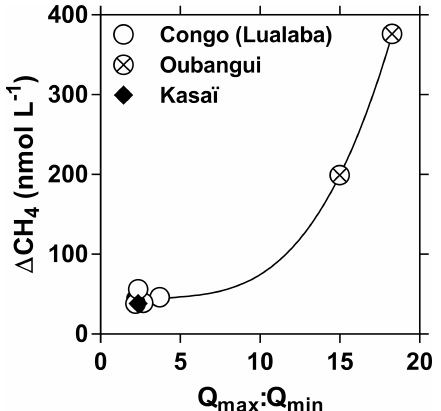
Figure 22. Seasonal amplitude of dissolved CH 4 concentration ( (cid:49) CH 4 in nmolL − 1 ) in surface waters as a function of the ra- tio of seasonal maximum and minimum of freshwater discharge ( Q max : Q min ) in the Congo (at Kisangani, 2013–2018), the Ouban- gui (at Bangui, 2010–2012) and the Kasaï (at Dima, 2015–2017) rivers (Fig.